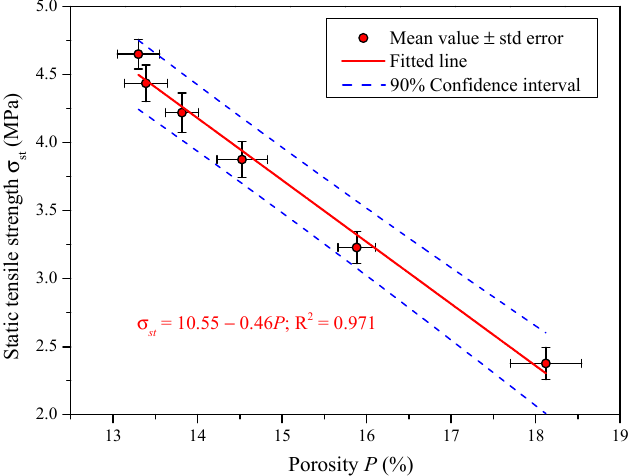
Figure 19. Static tensile strength of microwave irradiated sandstone vs. porosity.